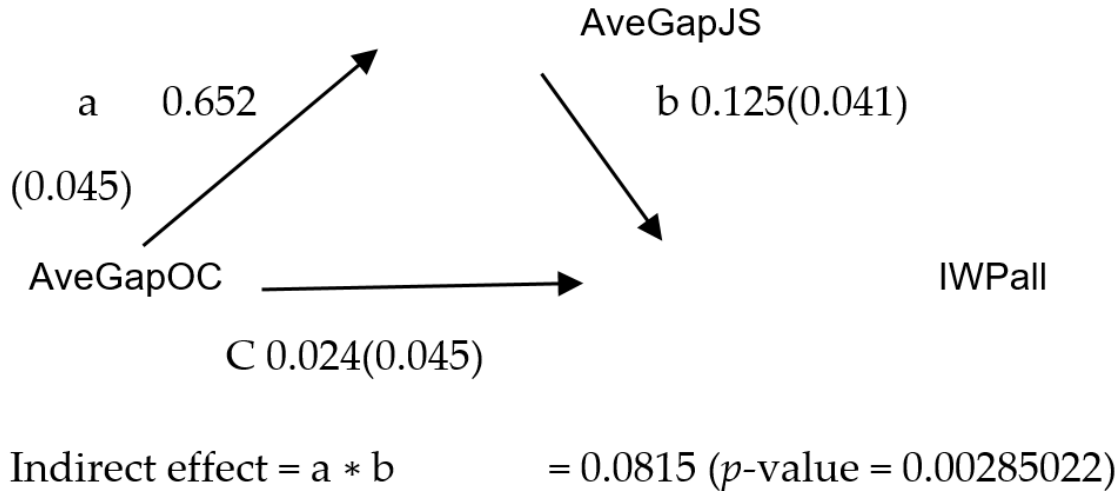
Figure 4. Mediating role of JSS in AveGapOC and IWP.